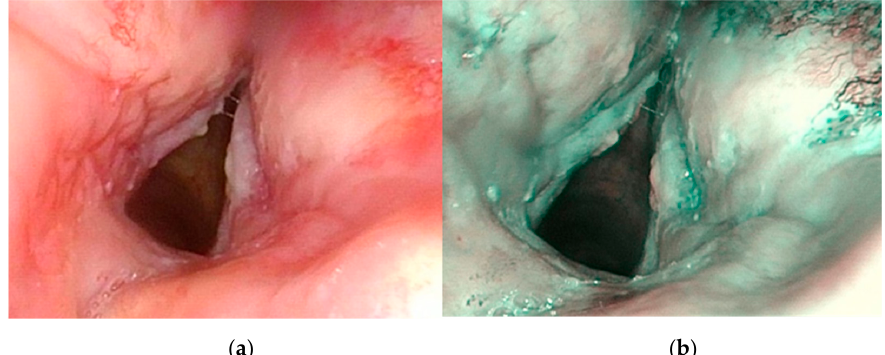
Figure 3. Patient, 65 years old, with history of laryngeal squamous cell carcinoma treated with chemoradiotherapy. Endoscopic appearance at one year follow-up. White light endoscopy (WLE) ( a ), Narrow band imaging (NBI) examination ( b ). Post-attinic microvascular alterations were suspicious for dysplasia and confirmed at histopathological exam. Table 3. Sensitivity, specificity, positive predictive value (PPV), positive negative value (PNV), accuracy and likelihood ratio of the four diagnostic modalities applied in group B.